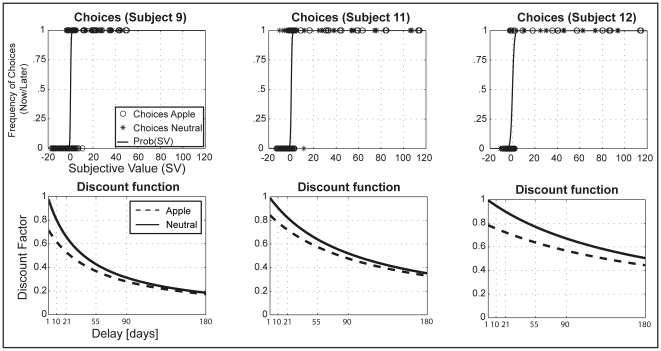
Behavioural results.The panels in the top row show actual choices by condition (Apple/neutral) and the fitted logistic functions for three example participants. The panels in the bottom row show participants' discount functions by condition (Apple/neutral), displaying the behavioral priming effect.